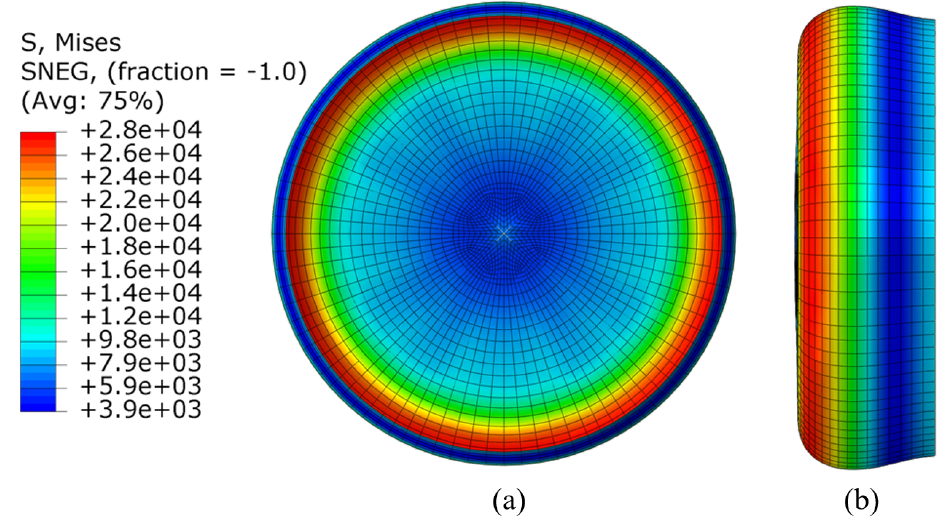
Figure 9. Von − mises stress analysis of the elastomer sensor under 1 cm pressing stroke of 1 cm: ( a ) Top view; ( b ) side